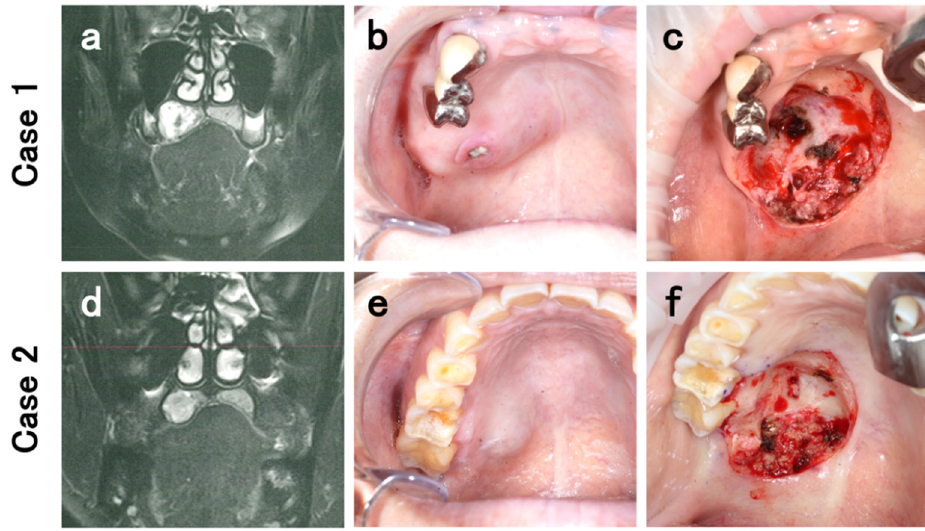
Figure 1. ( a ) On T2-weighted magnetic resonance imaging (MRI) shows an internal non-uniformly enhanced tumor mass, which led to pressure absorption of the palatal bone but invasion of the sinus and nasal cavity was not evident. ( b ) Intraoral view before the resection revealed a hard, elastic mass in the right side of the hard palate, sized 2.5 × 2 cm. Biopsy site was residual as an ulcerous region. ( c ) Intraoral view after the resection. Greater palatine artery and nerve were ligatured and cut. The tumor was resected including the surrounding gingiva and the periosteal, and a layer of the palatal bone was shaved off. ( d ) Similar to Case 1, T2-weighted MRI showed an internal non-uniformly enhanced tumor mass, which led to pressure absorption of the palatal bone but invasion of the sinus and nasal cavity and significant cervical adenopathy were not evident. ( e ) First intraoral examination revealed a hard, elastic mass in the right side of the hard palate, sized 1.8 × 1.6 cm and without ulceration. ( f ) Intraoral view after the resection. Greater palatine artery and nerve were ligatured and cut. The tumor was resected including the surrounding gingiva and the periosteal, and a layer of the palatal bone was shaved off.